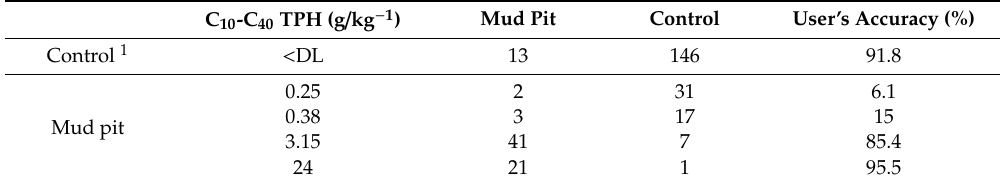
Table 4. Confusion matrix obtained from the RLR classification on the validation sites using the 14 vegetation